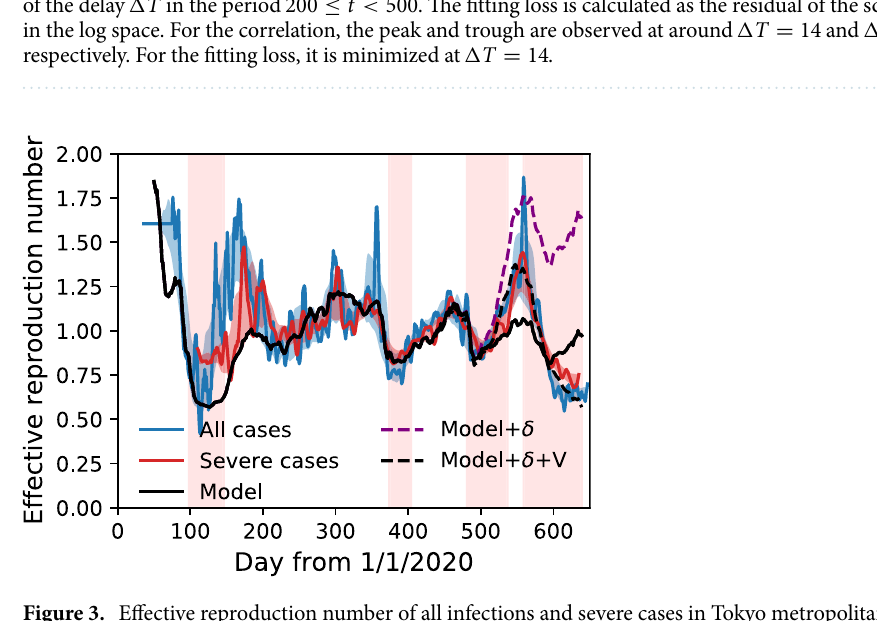
Figure 3. Effective reproduction number of all infections and severe cases in Tokyo metropolitan area compared to the model result. The effective reproduction number is plotted with a delay of 14 and 26 days for all and severe cases, respectively. Parameter fitting is done in the span 200 ≤ t < 500 . ‘Model’ indicates the prediction from human mobility alone, ‘Model + δ ’ includes the effect of the Delta variant, and ‘Model + δ + V’ additionally includes the effect of the